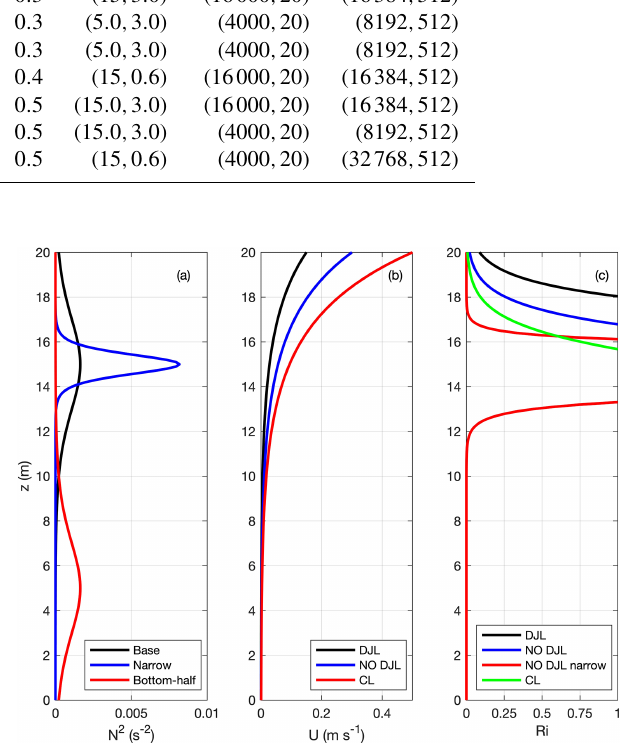
Figure 2. Background profiles. (a) N 2 (z) , (b) U(z) , (c) Ri